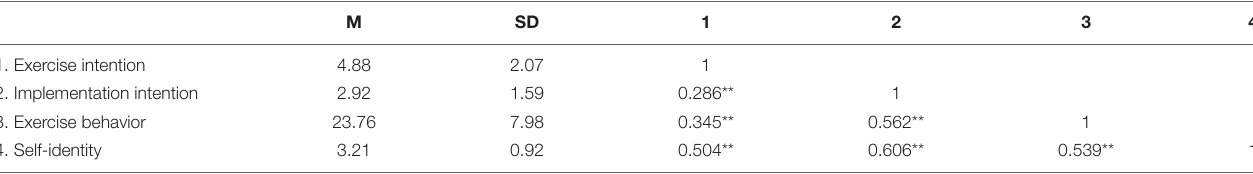
TABLE 3 | Mean, standard deviation, and correlation coefficient of variables. M SD